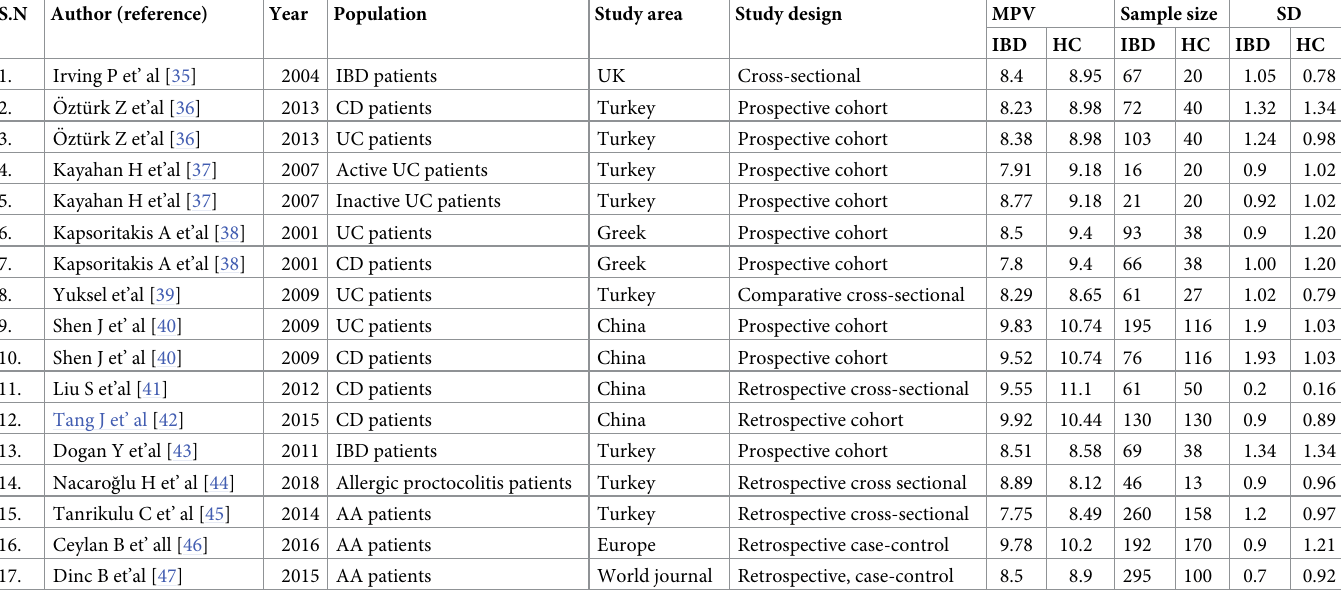
Table 1. Summary characteristics of studies included in meta-analysis.